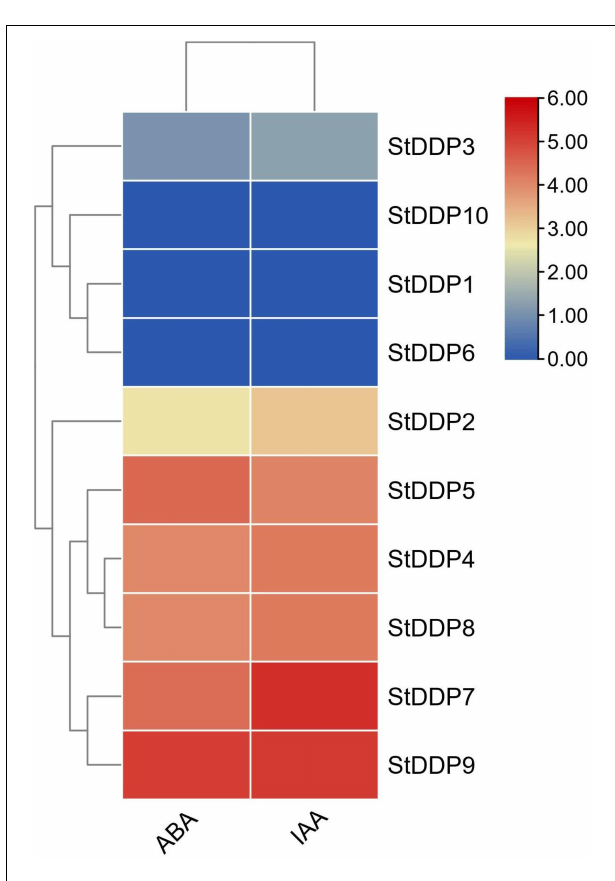
FIGURE 9 | Expression profiling of StDDP genes in response to ABA and